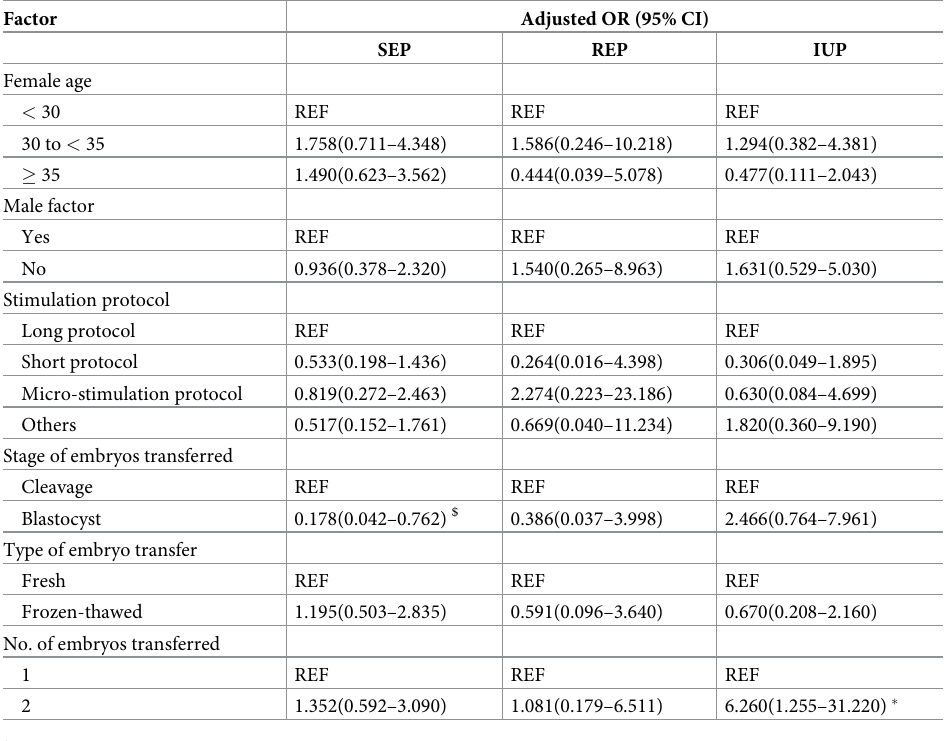
Table 6. Risk factors associated with EP by logistic regression